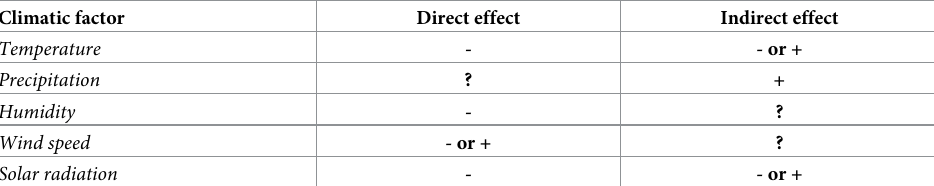
Table 1. Expected direct and indirect climatic